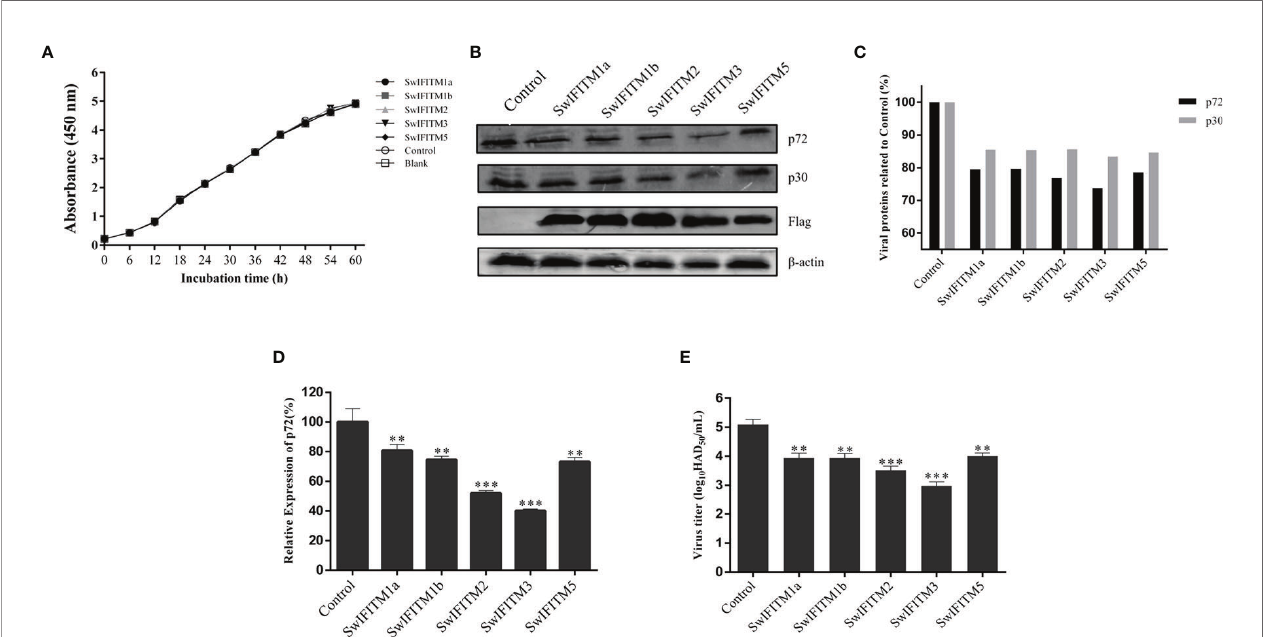
FIGURE 4 | Overexpression of SwIFITMs Inhibits ASFV replication. pEF-SwIFITMs with FLAG tags were transfected into WT Vero cells separately for 24 h and then infected with 0.1 MOI of ASFV; (A) the cells viability was detected by cell proliferation assay; (B, C) the virus replication levels of ASFV were determined by western blotting at 36 hpi, and band densitometry for each protein was determined, and the density quantitative ratios of each viral or SwIFITM protein and b -actin were calculated, ratio of SwIFITM protein and b -actin served as a control; (D) the expression levels of p72 protein were detected by RT-qPCR with b -actin used as a control at 36 hpi; (E) the viral titration of progeny virus was tested in HAD assay. Samples were analyzed in triplicate, and three independent experiments were performed. ** p <0.01; *** p <0.001; vs empty vector control group. Error bars indicate standard